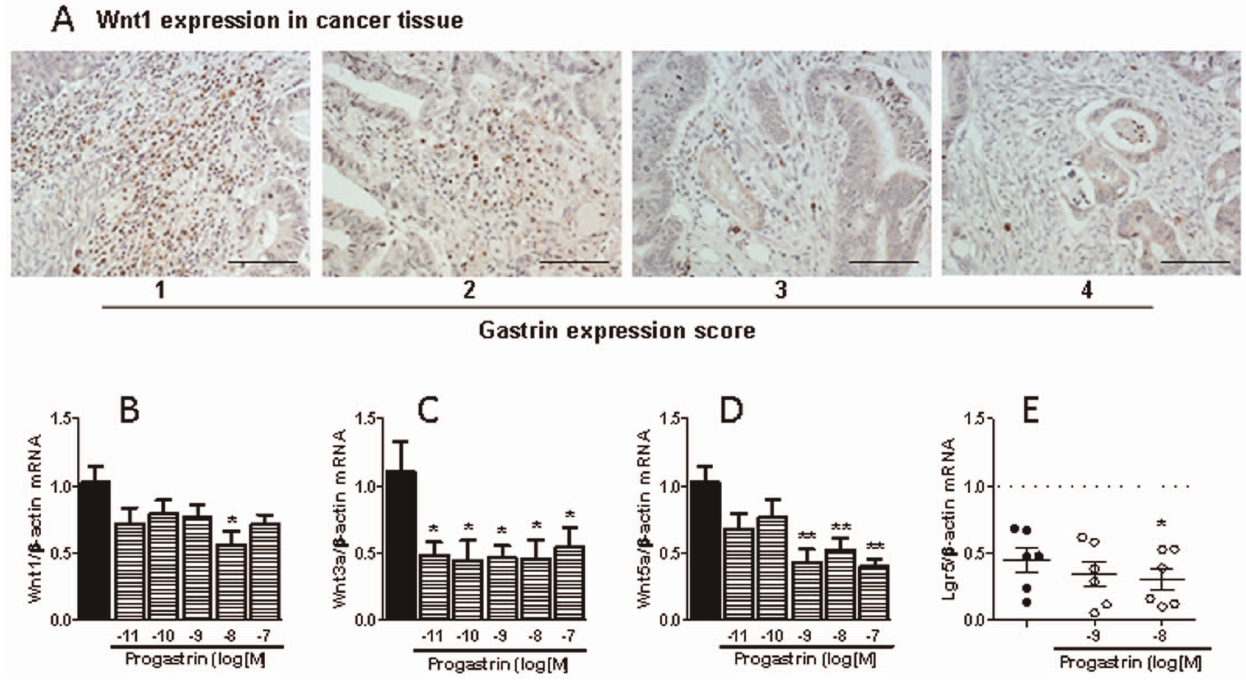
Figure 5. Influence of progastrin on macrophage-derived Wnt ligands. Immunoreactivity to Wnt1 in the stroma of colorectal cancer in relation to the expression of gastrin in the same tissue (scale bar =0.2 mm) (A); and effects of the presence of progastrin during differentiation of human peripheral monocytes to macrophages on mRNA expression of three different Wnt ligands in these macrophages (B–D, n=5) and mRNA expression of Lgr5 in co-cultured Caco-2 cells (E, n=7). Bars represent mean 6 SEM. *P , 0.05 and **P , 0.01 vs corresponding value in vehicle-treated cells.